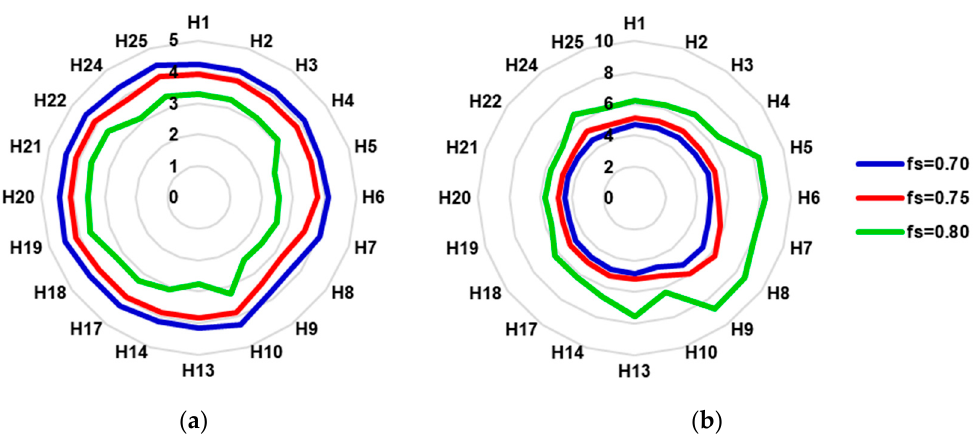
Figure 5. ( a ) Ratio: energy/CAPEX (kWh/€ per year); ( b ) payback calculated for each investment (years).